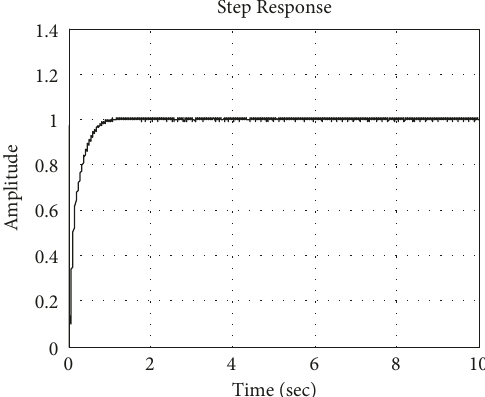
Figure 19: Response curve at 2 times r.